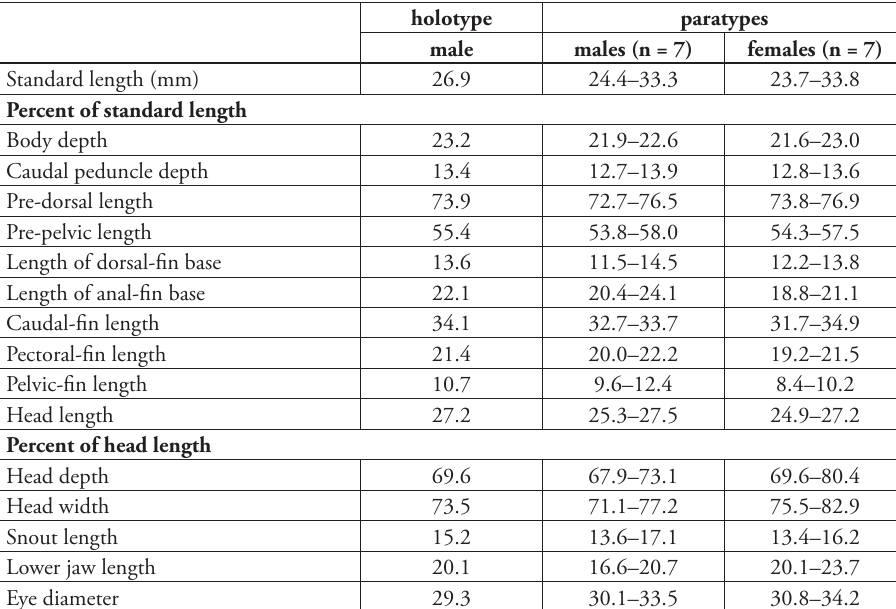
Table 3. Morphometric data of Melanorivulus regularis